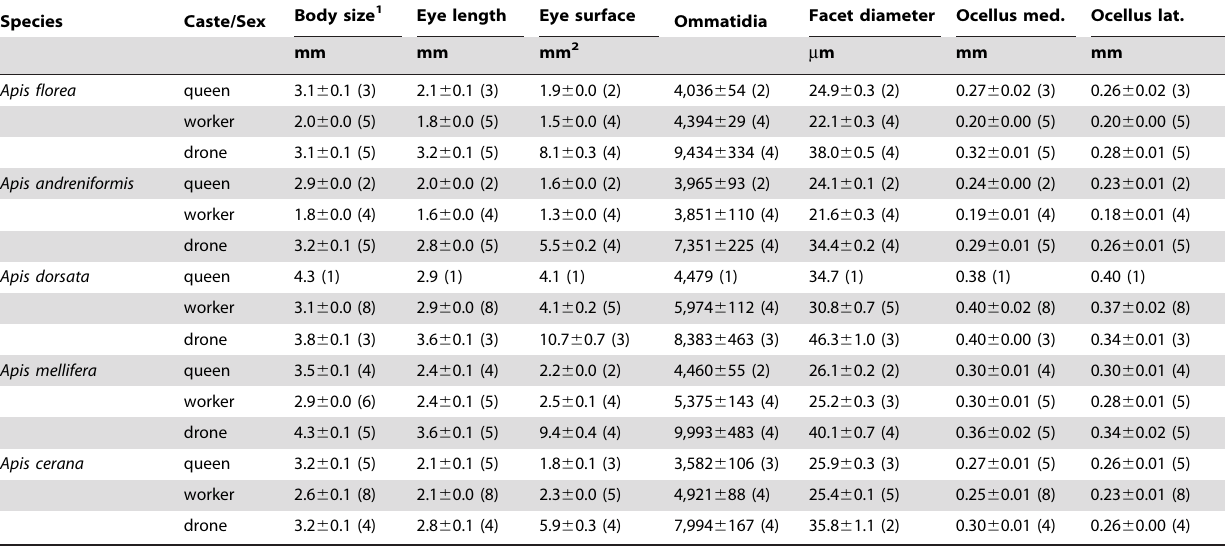
Species Caste/Sex Body size 1 Eye length Eye surface Ommatidia Facet diameter Ocellus med. Ocellus